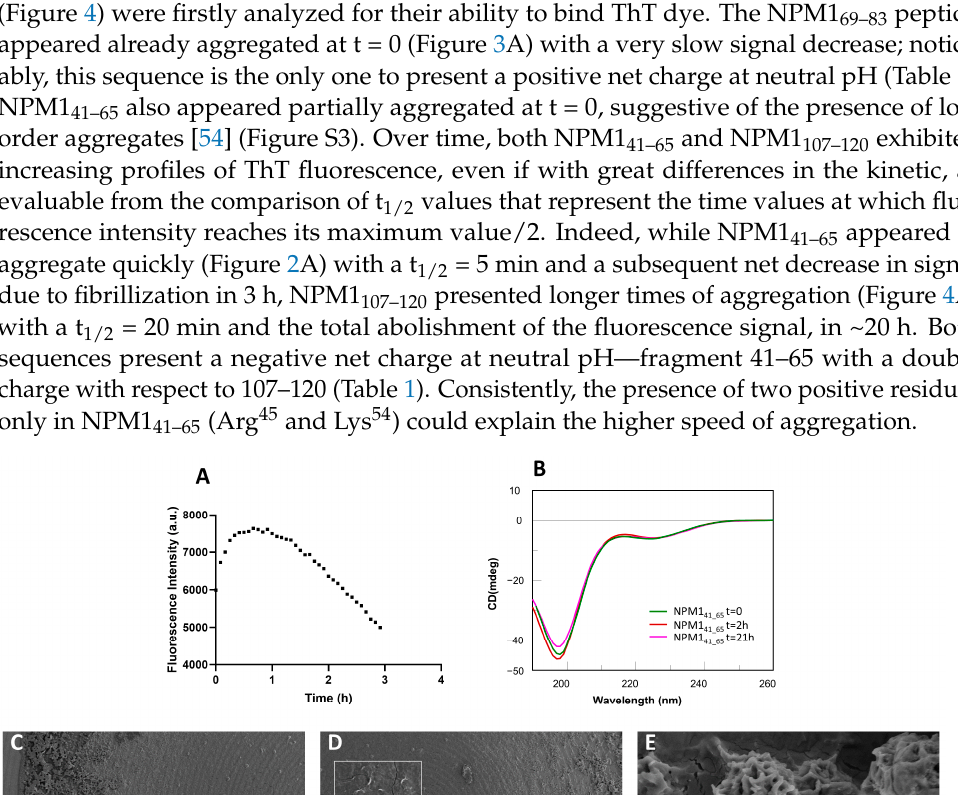
Figure 3. NPM1 69–83 characterization: ( A ) Time course of ThT fluorescence emission intensity; ( B ) CD spectra over time; ( C – E ) SEM micrographs registered at 24 h at 100, 20 and 2 µm. Figure 4. NPM1 107–120 characterization: ( A ) Time course of ThT fluorescence emission intensity; ( B ) CD spectra over time; ( C – E ) SEM micrographs registered at 24 h at 200, 20 and 2 µm.